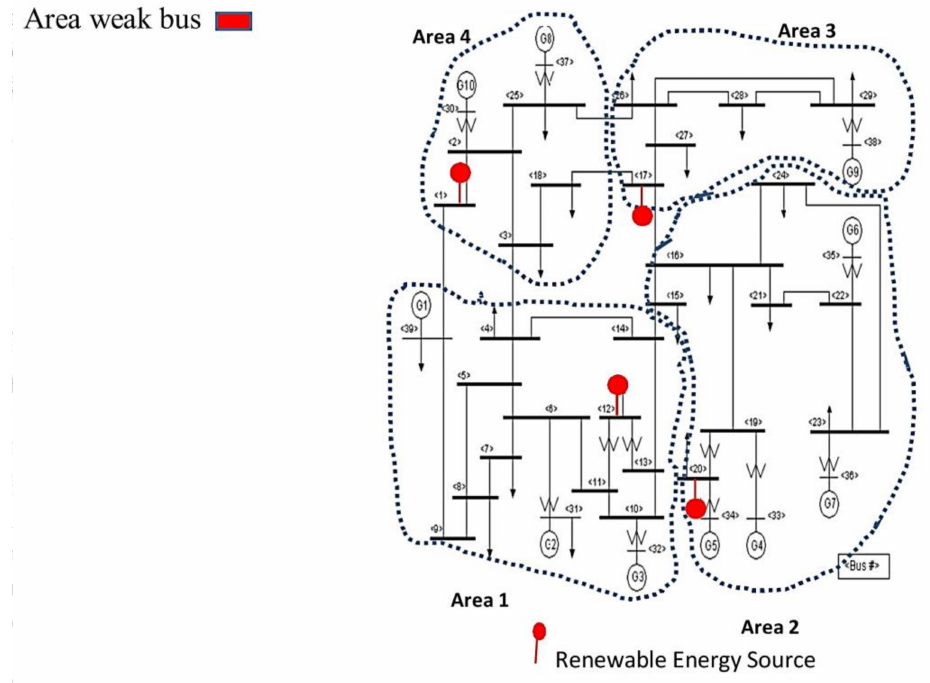
Figure 10. The New England 39-bus system with renewable-energy sources.